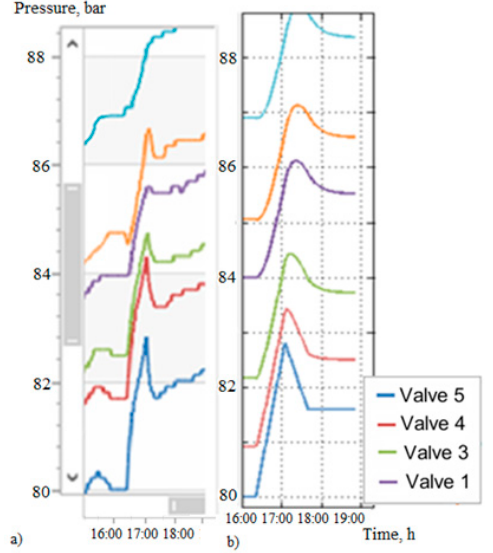
Figure 12. The dynamics of pressure surge propagation: ( a ) actual manometric measuring, ( b ) the results of computer simulation. The valves correspond to Figure 1.